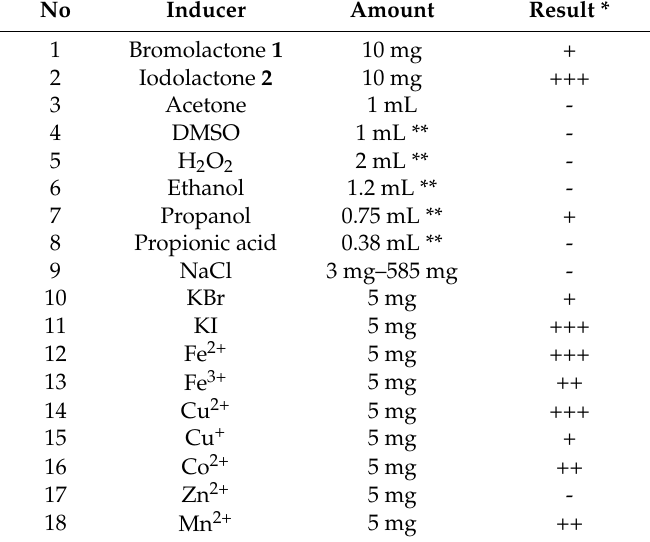
Table 4. Potential impact of inducers on macrosphelide 4 production after 7 days (according to GC-FID). No Inducer Amount Result * 1 Bromolactone 1 10